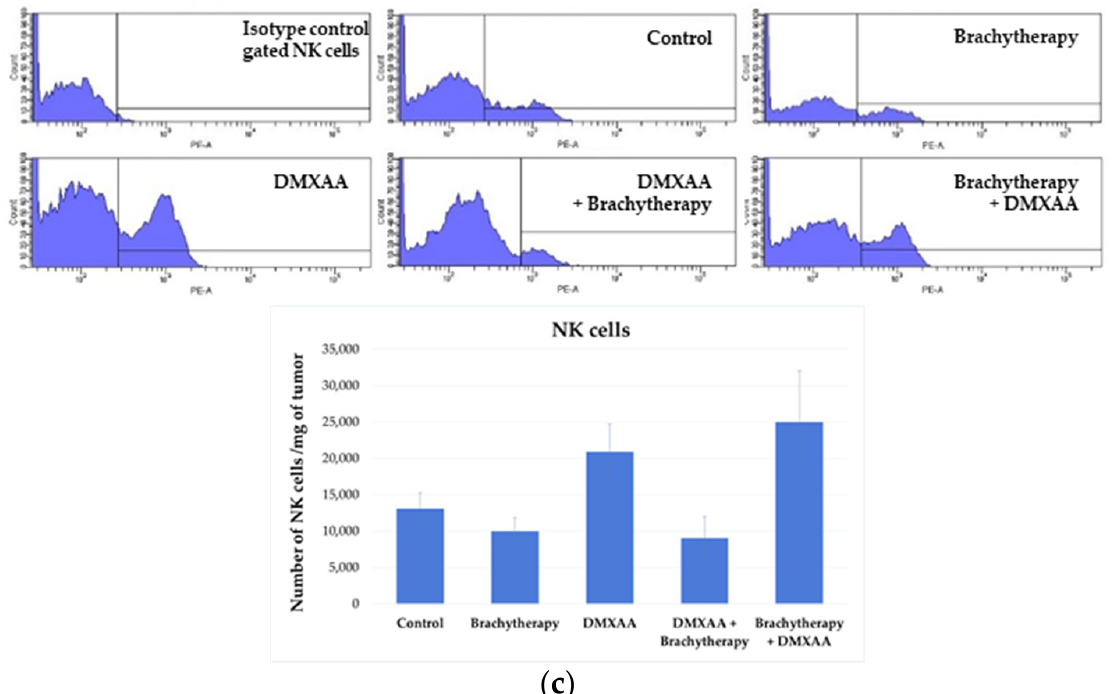
Figure 7. Determination of immune cells infiltration using cytometry analysis. Twenty days after tumor inoculation tumors were collected. ( a ) Gating strategy of flow cytometry. After gating the population of single cells, viable lymphocytes with negative 7-AAD and positive CD45 staining were selected. ( b ) Representative flow cytometry dot plot graphs of CD8 + and CD4 + T cells for each experimental group. The number of CD8 + and CD4 + T lymphocytes was determined in the total viable CD45 + cells using appropriate antibodies. ( c ) Representative flow cytometry histograms of NK cells for each experimental group. The number of NK cells was determined in the total viable CD45 + cells using appropriate antibodies. Analysis was performed in at least 7 tumors of each group. In all experimental groups selected cells were gated to appropriate isotype control for each tumor individually. The number of immune cells was determined in a Lympholyte gradient enriched cell population. Total number of CD8 + , CD4 + and NK cells was calculated per mg of tumor